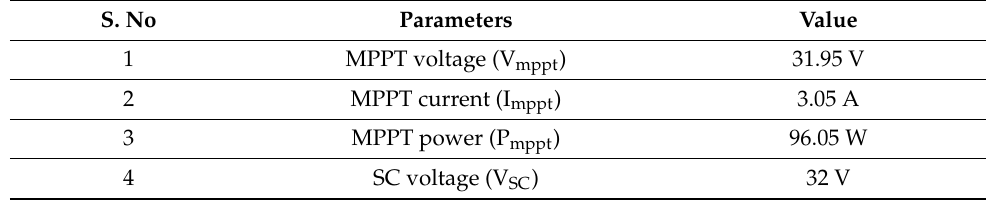
Table 5. Simulation study system